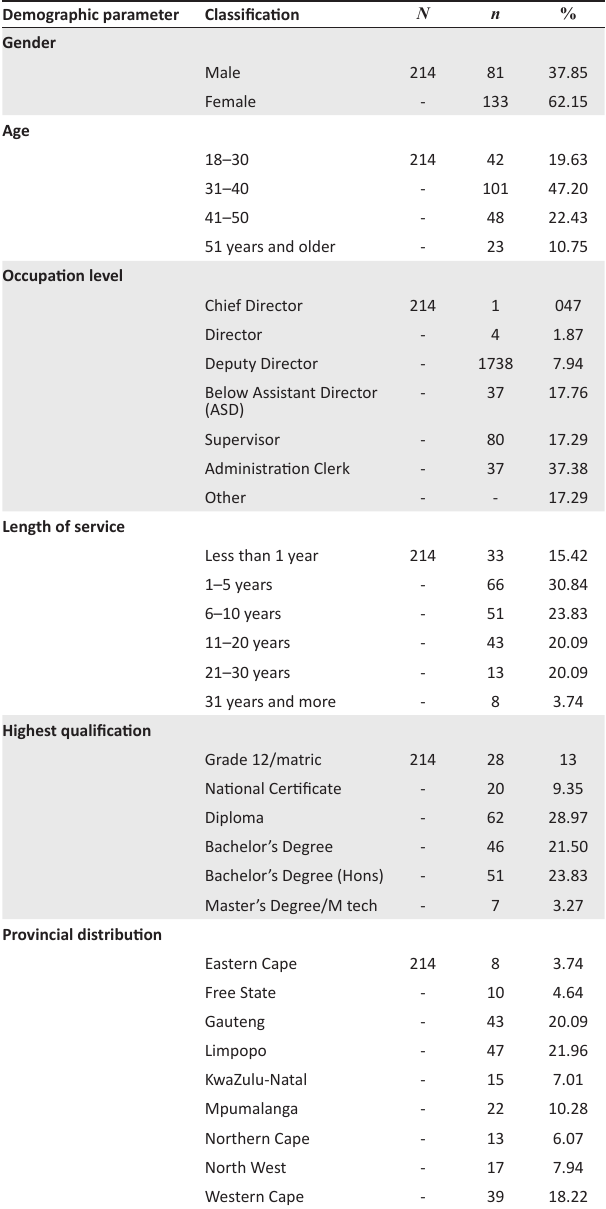
TABLE 1: Profile of the respondents. Demographic